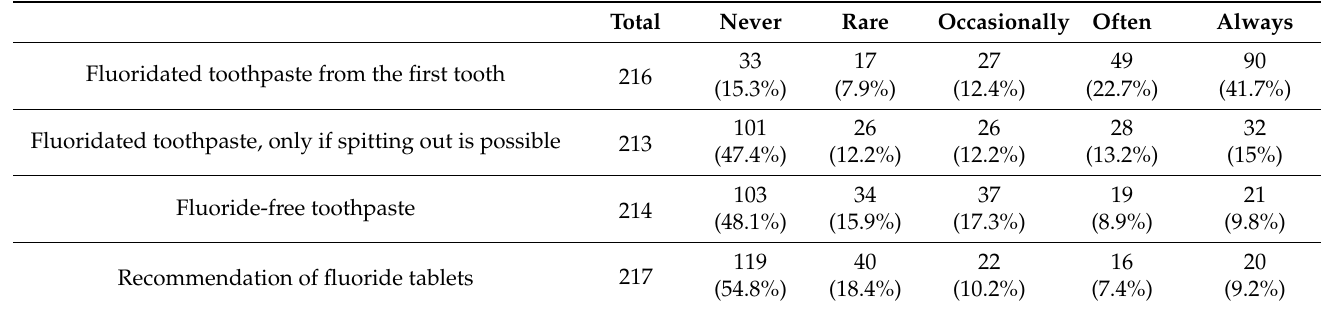
Table 6. Fluoride recommendations of midwives in absolute values and in percentages